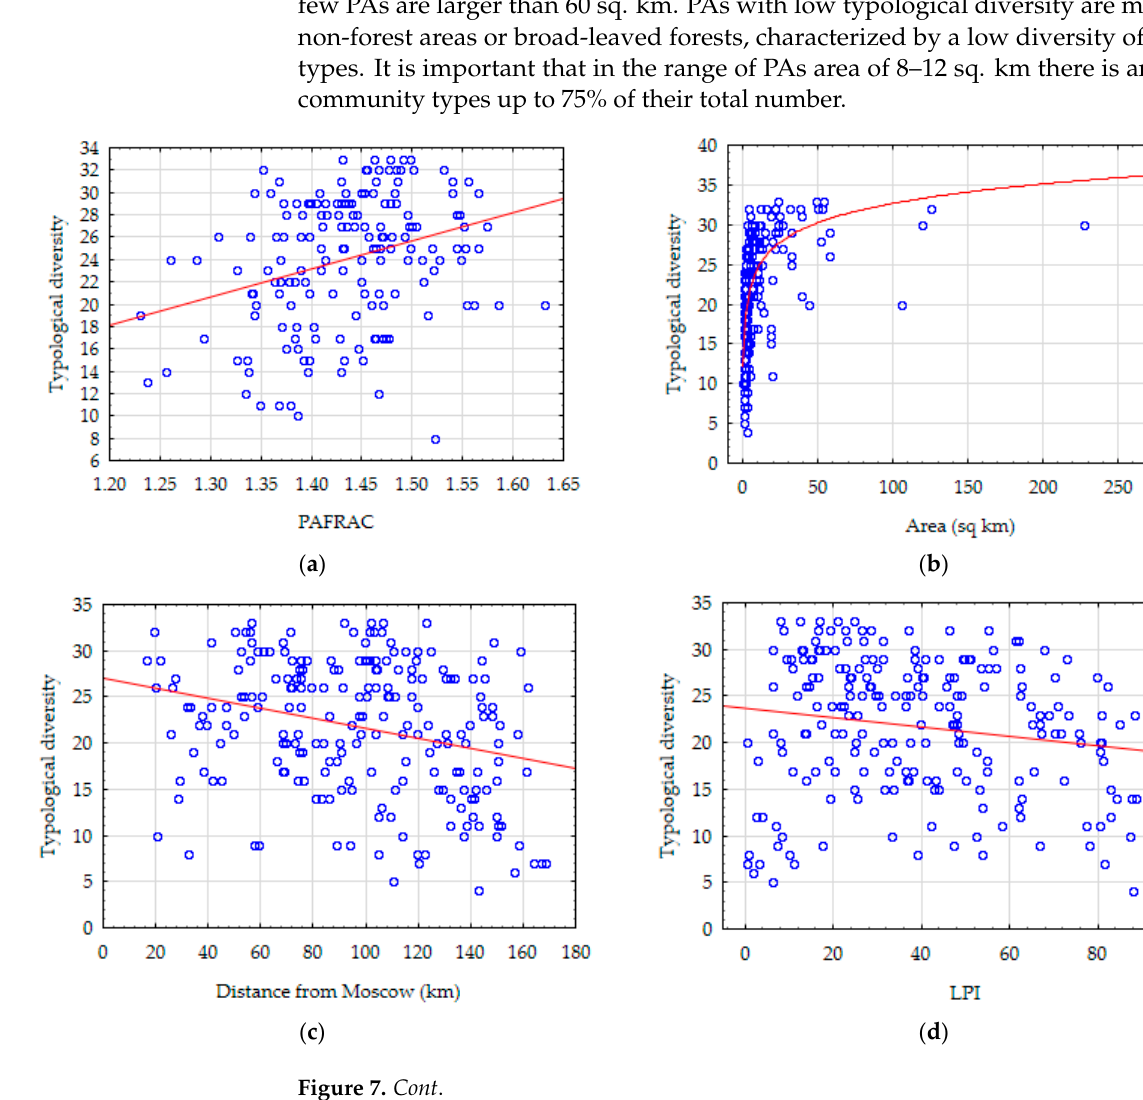
( f ) Figure 7. Scatterplots and approximating functions between typological diversity and environ- mental variables: ( a )—PAFRAC, ( b )—area of PAs, ( c )—distance to Moscow, ( d )—LPI, ( e )—TECI, ( f )—establishment date.